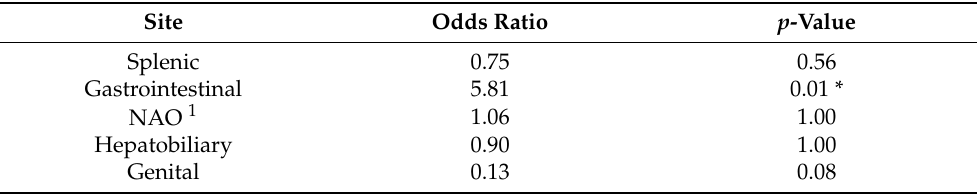
Table 3. Odds ratio of malignancy of abdominal lesions in different